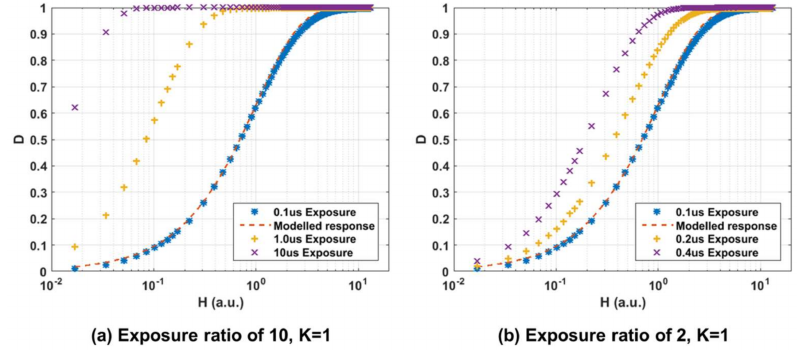
Figure 9. Measured normalized intensity (D or ‘Bit plane density’) to normalized input signal (H) for two sets of integration times for 1 photon threshold (K = 1). ( a ) Exposure ratio of 10 with Short = 100ns, Mid = 1 µ s, Long = 10 µ s. ( b ) Exposure ratio of 2 with Short = 100 ns, Mid = 200 ns, Long = 400